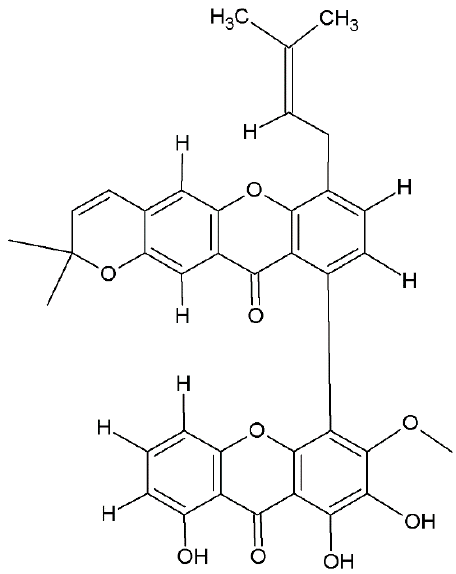
Figure 5. Structure of globulixanthone E, bisxanthone.